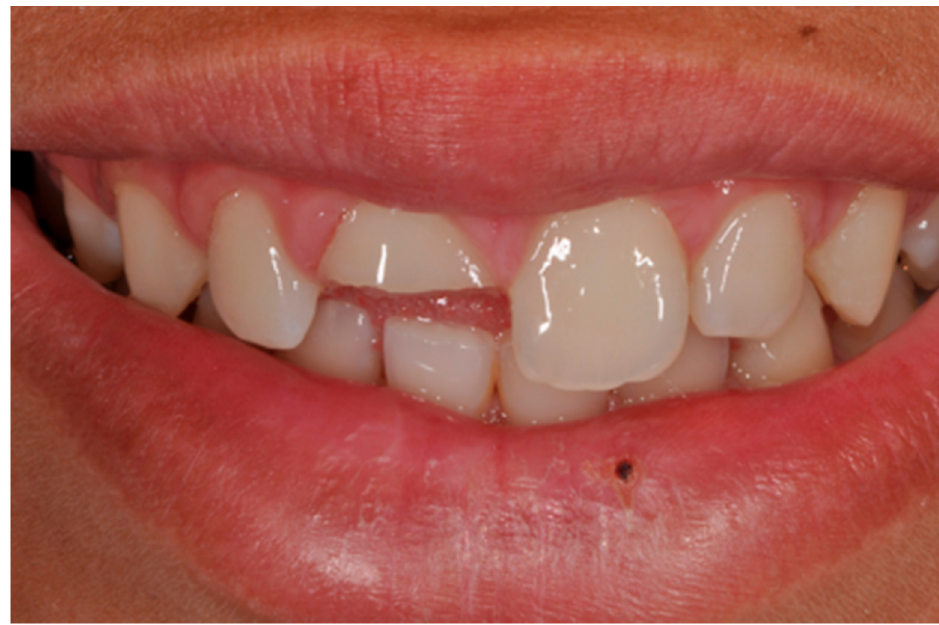
Figure 1. Initial clinical situation. Reprinted from Restauri diretti nei settori anteriori, G. Paolone, S. Scolavino, © 2021, with permission from Quintessence Publishing Italy.